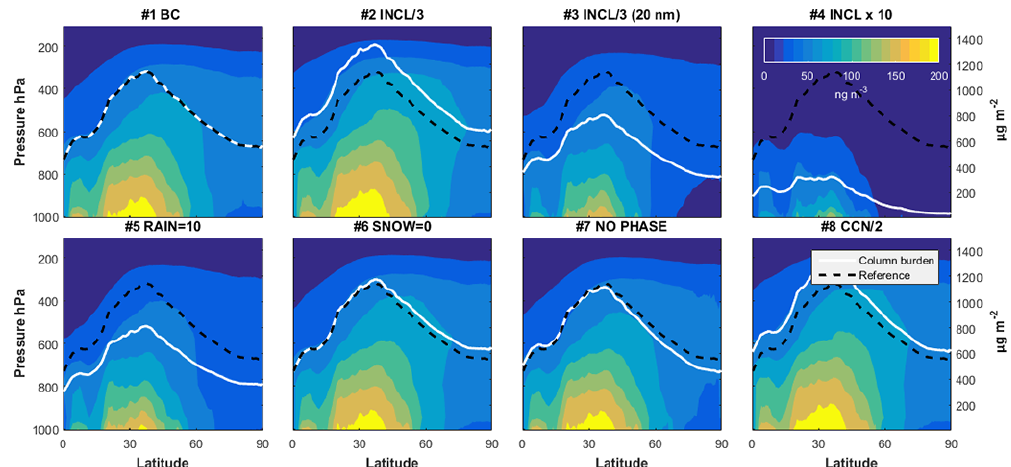
Figure 6. Northern Hemisphere vertical distribution of BC for eight different settings of the removal parameters. Top left panel shows the concentrations for the reference settings for BC. The other panels show results of the sensitivity simulations (see Table 4 for details). Five vertical layers were used and the horizontal resolution is 0.5 ◦ . The white line is the latitudinal column burden for each simulation and the dashed black line repeats the results for the reference BC simulation, for comparison